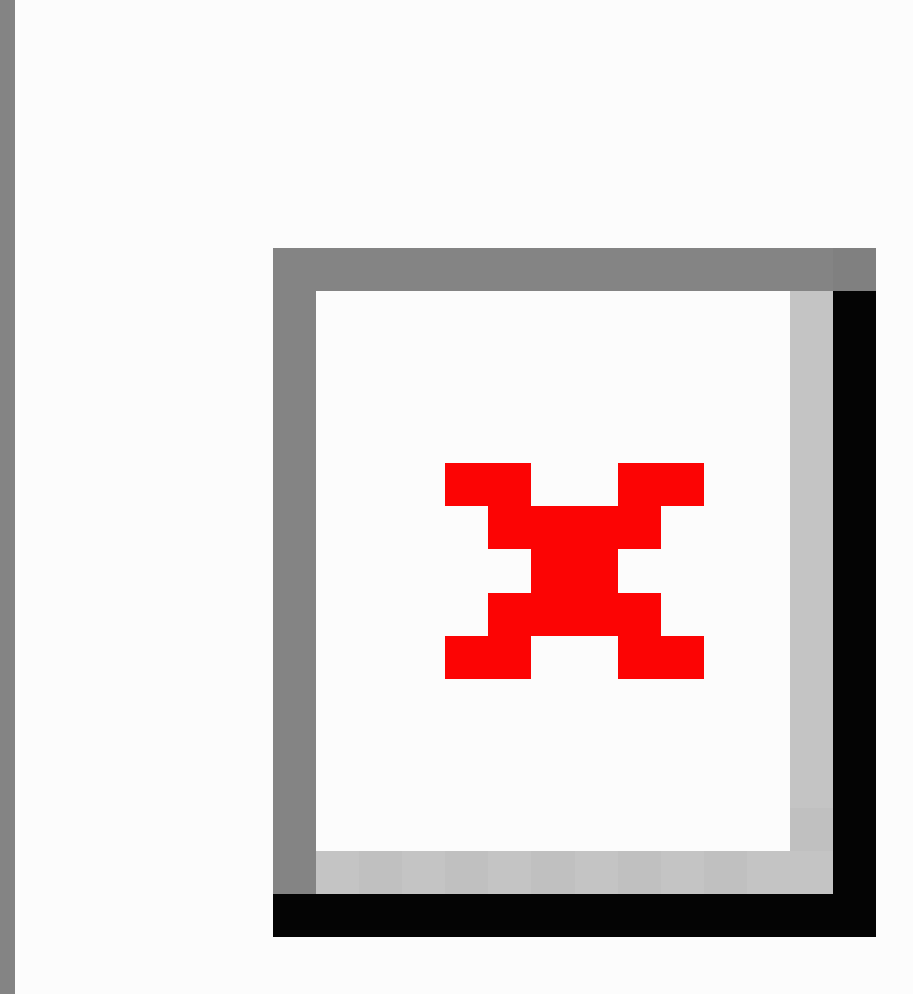
Figure 11. Steps in generating the LPAD